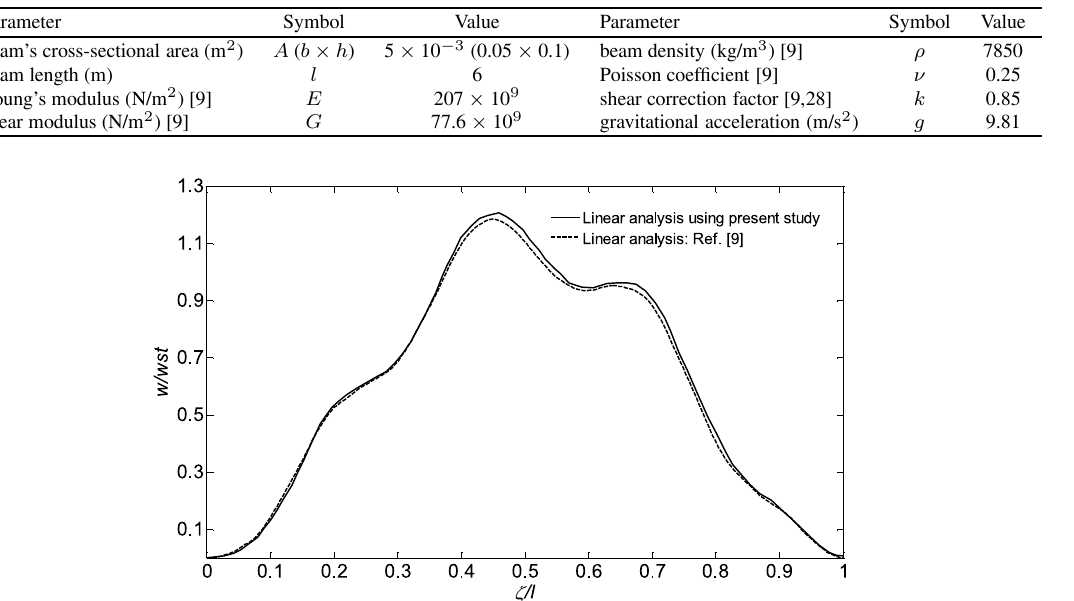
Fig. 2. Instantaneous normalized vertical displacement under a moving mass of m . (—–) linear analysis using present study, ( ) linear analysis: Ref. [9].